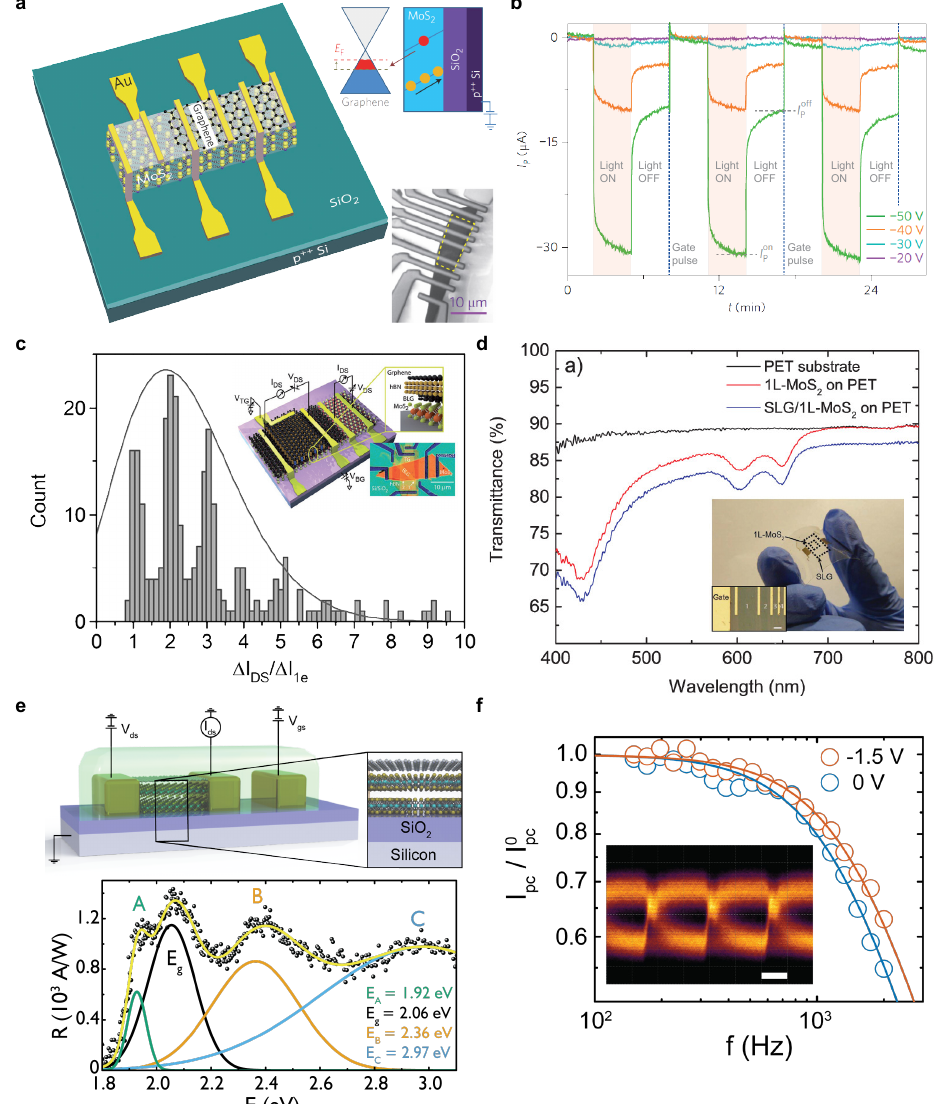
Figure 7. TMD-graphene hybrids. ( a ) schematic of MoS 2 -graphene photodetector with scanning electron microscope (SEM) image of device (lower inset) and principle of operation (upper inset); ( b ) temporal response of photocurrent from device in ( a ) under illumination and gate pulse cycles. Reproduced with permission from Roy et al. [100] Copyright 2013, Nature Publishing